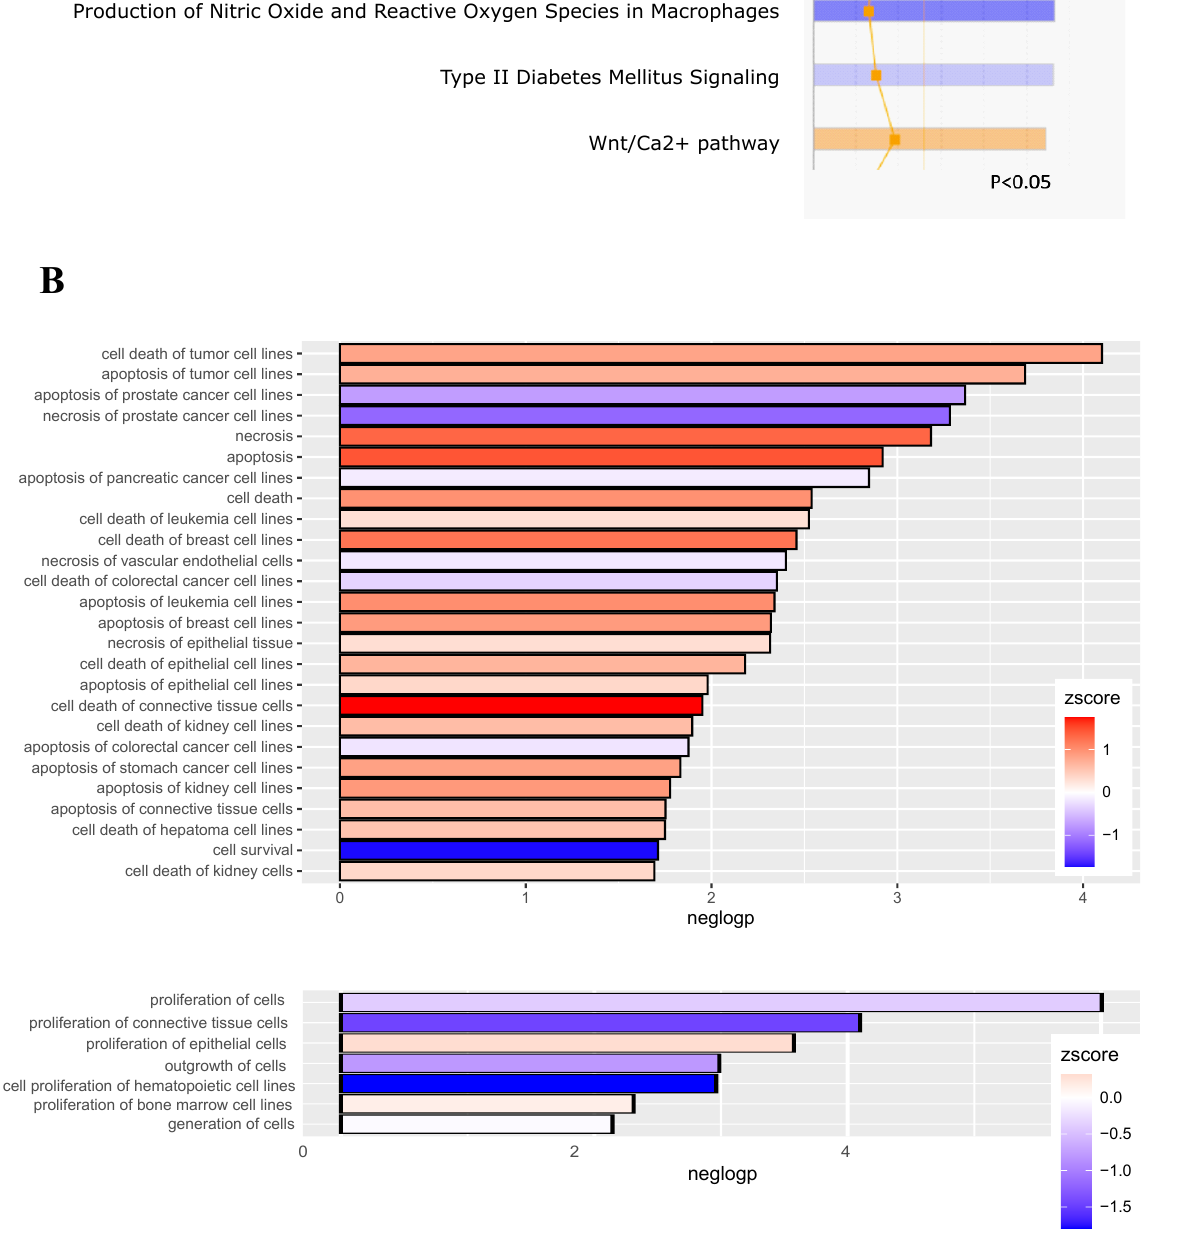
Figure 3. Antiandrogen treatment of LNCaP cells upregulates NF- κ B signaling and reduces cell death of prostate cancer cells. A public microarray dataset of LNCaP cells treated with the antiandrogen bicalutamide (GEO database, GSE56188) was reanalyzed with the Ingenuity Pathway Analysis software. ( A ) Depiction of canonical pathways, showing NF- κ B signaling significantly enhanced (orange color reflects a positive z-score, indicated by a black box). ( B ) Disease/function analysis implying that apoptosis, as well as necrosis, of prostate cancer cell lines is reduced, as reflected by the blue color (indicating a negative activation z-score), while cell death of most other cells is elevated. Lower panel: effect on proliferation of cells. Significantly altered biological functions are plotted (using the ggplot2 package of R Bioconductor) with negative log- p -values on the x